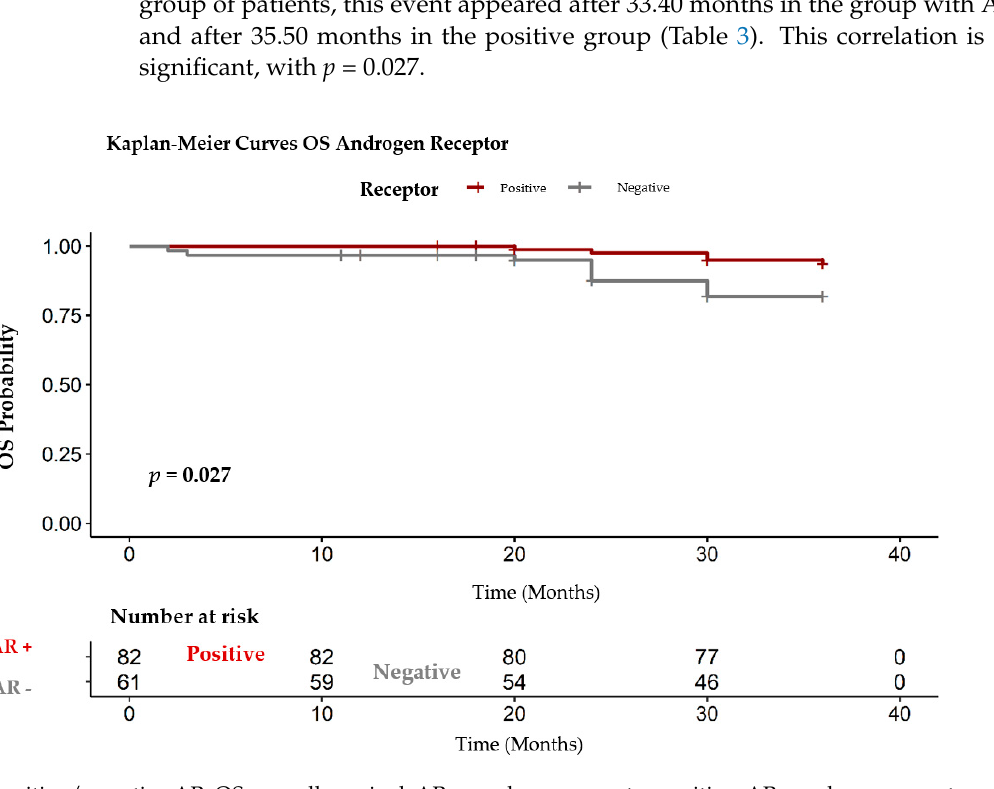
Figure 7. OS positive/ negative AR. OS: overall survival, AR +: androgen receptor positive, AR ‐ : androgen receptor negative Table 3. OS AR survival data.